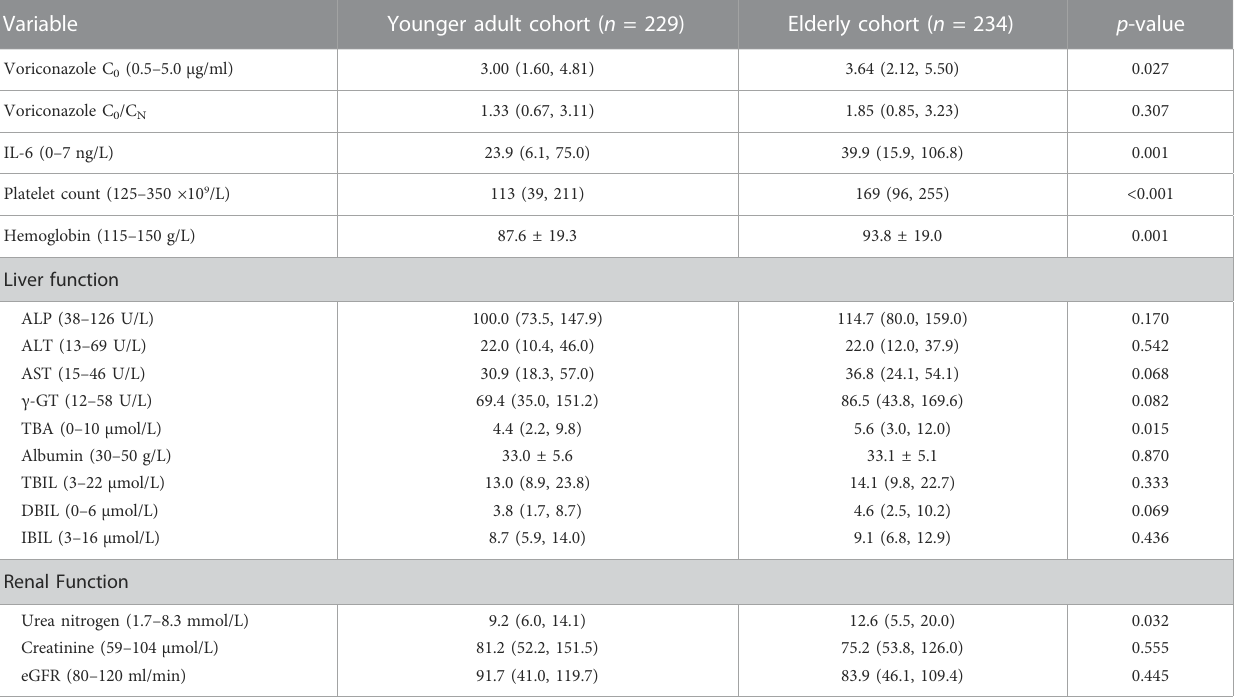
TABLE 2 Laboratory data of patients in the two cohorts. Variable